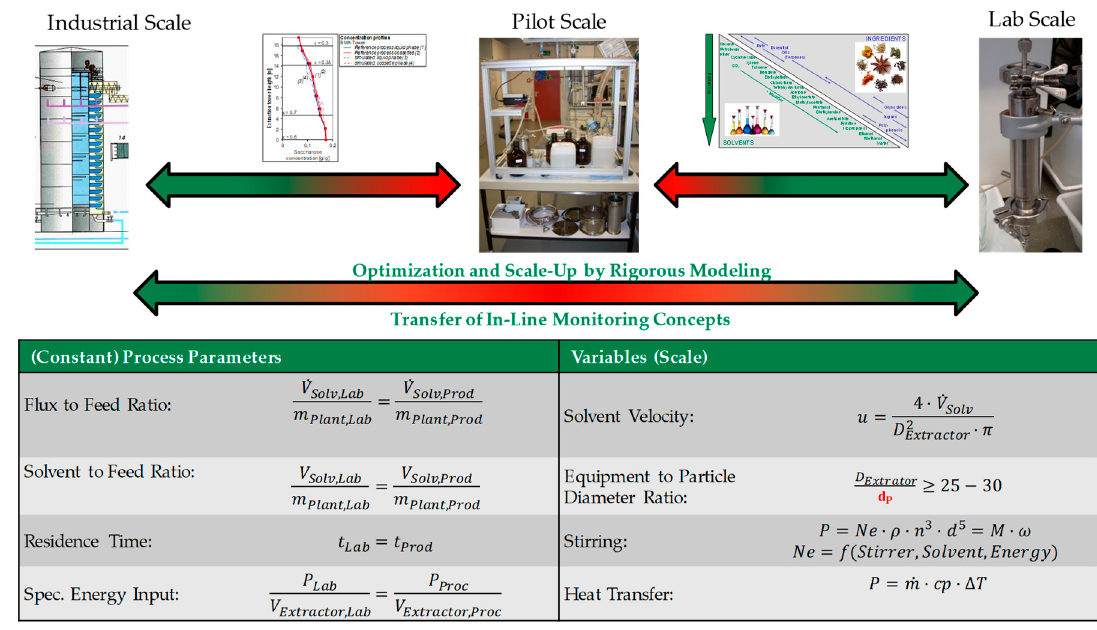
Figure 7. Scaling of laboratory equipment from production scale [20,32].